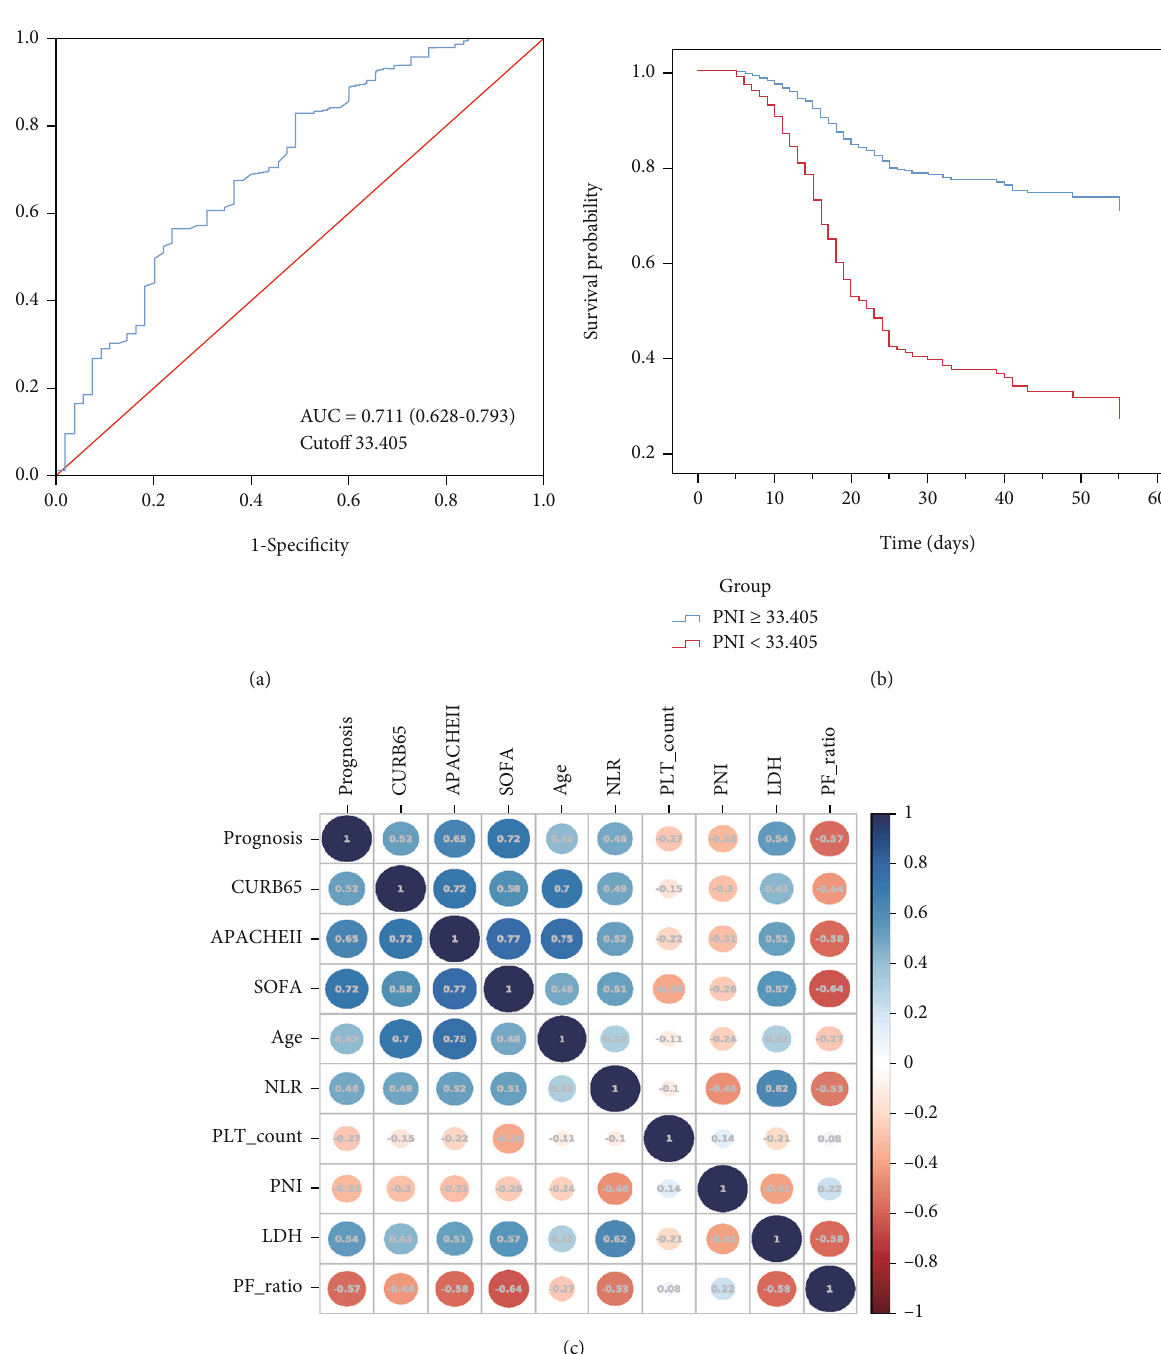
Figure 4: The signi fi cance of the PNI score for the prediction of mortality in patients with severe COVID-19. (a) ROC curve of PNI; (b) Cox analysis of COVID-19 patients based on the cuto ff value of the PNI score; (c) correlation between the PNI score and other indicators of disease